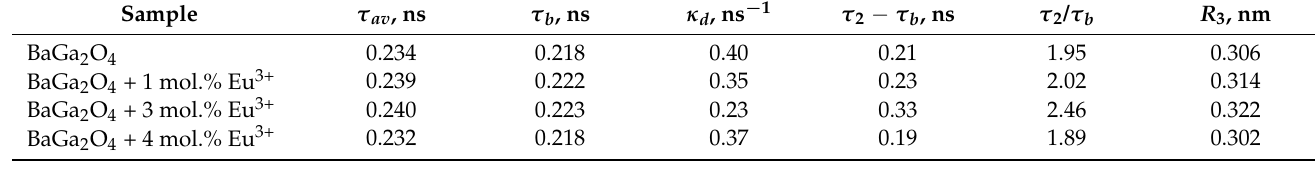
BaGa 2 O 4 + 4 mol.% Eu 3+